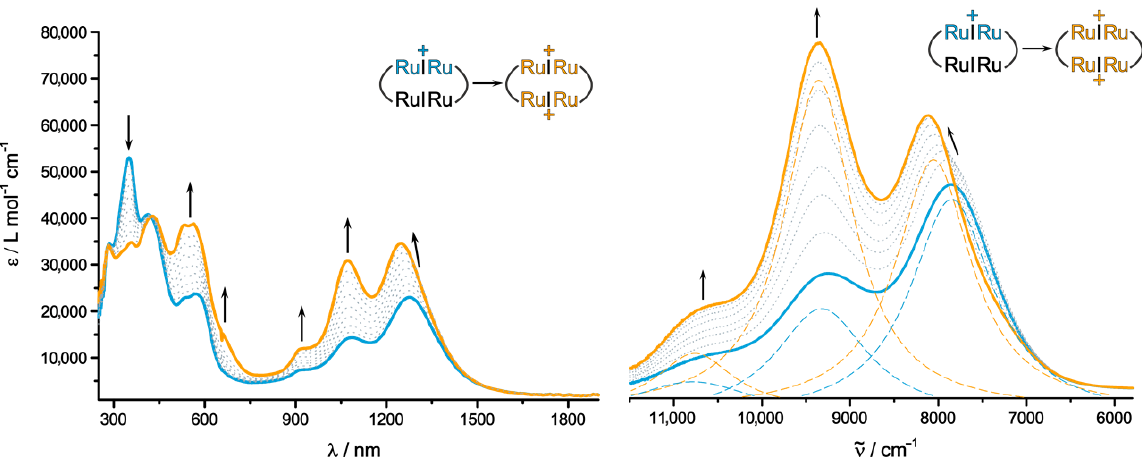
Figure 10. Changes in the UV/Vis/NIR spectrum (DCE, 0.05 M NBu 4 BAr F24 , r.t.) of 2 Ru 2 Ph-Croc during the second oxidation ( left ) with corresponding magnification of the IR/NIR range ( right ). The broken blue and orange lines denote the positions of the individual sub-bands according to spectral deconvolution.